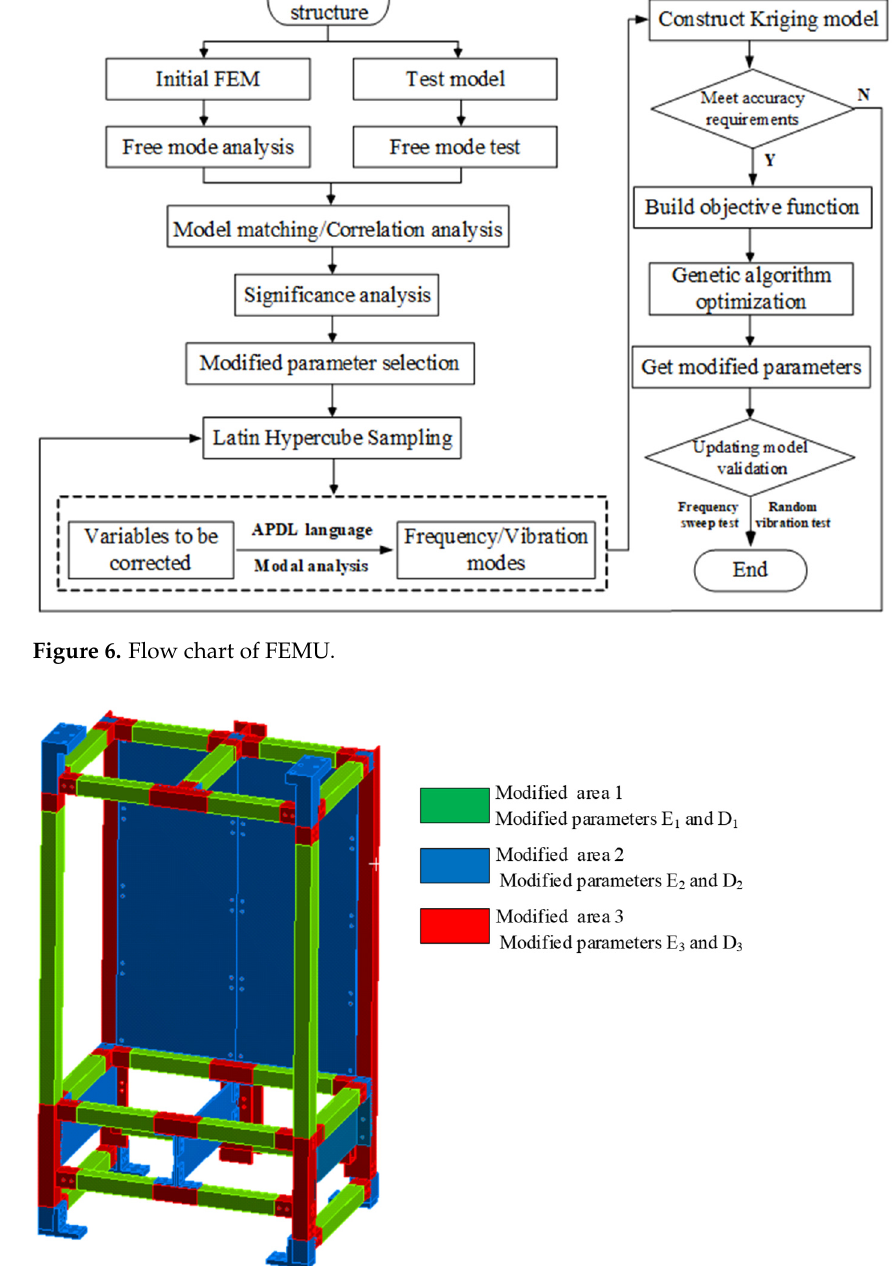
frequencies after modal matching: the first, second, fourth, fifth, seventh, and ninth Table 4. The 7-factor, 3-level orthogonal table.